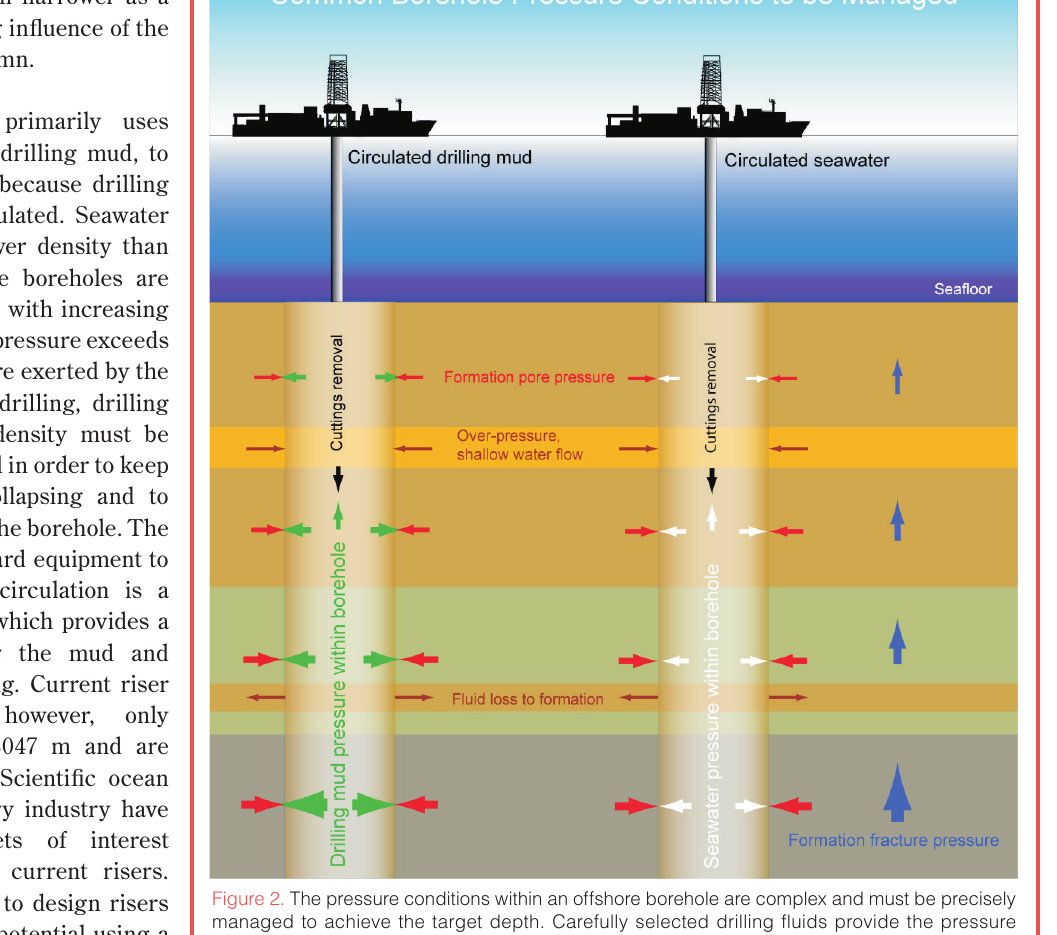
pressure (Fig. 3, red line) and the formation fractureFig. 3, red line) and the formation fracturered line) and the formation fracture pressure (blue line), thereby avoiding wellbore instability.